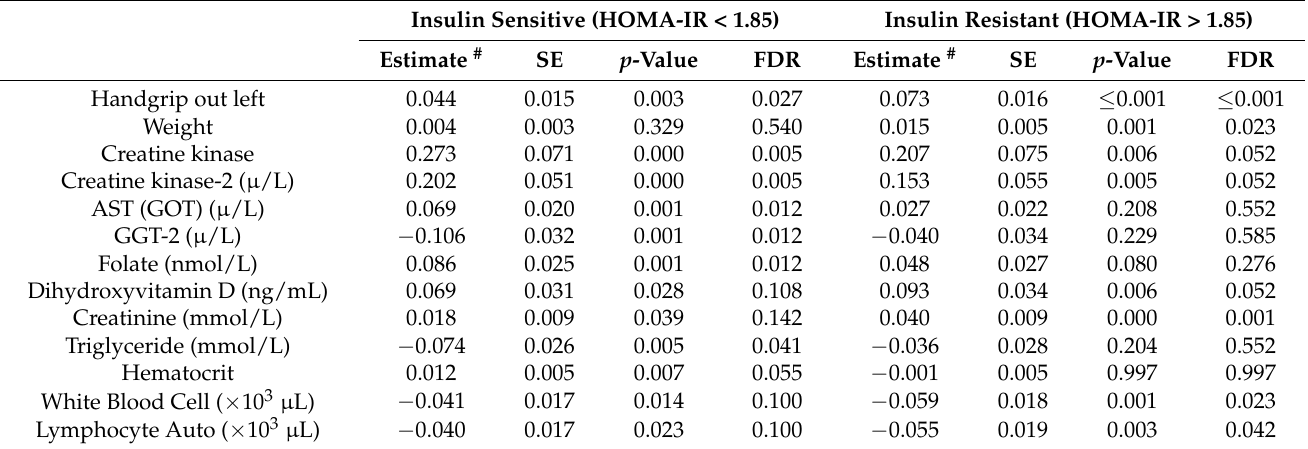
Table 2. Linear regression analysis evaluating the association between physical activity and the metabolic profiles in each HOMA-IR category.